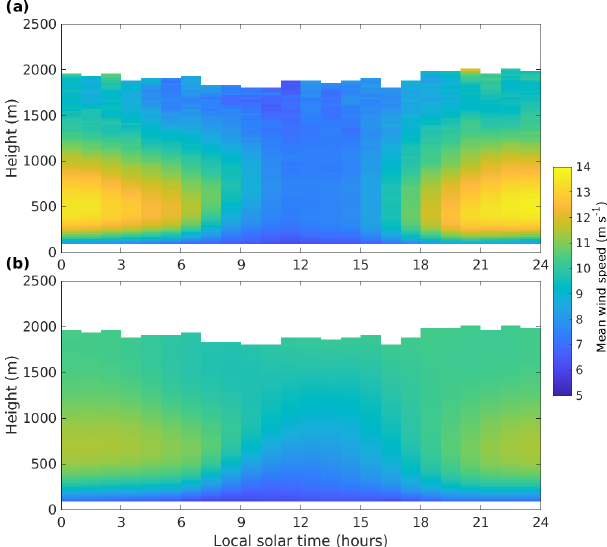
Figure 11. Composites of (a) Doppler lidar and (b) IFS mean wind speed at SGP when low-level jets were detected in the Doppler lidar data. Time refers to approximate local solar time.